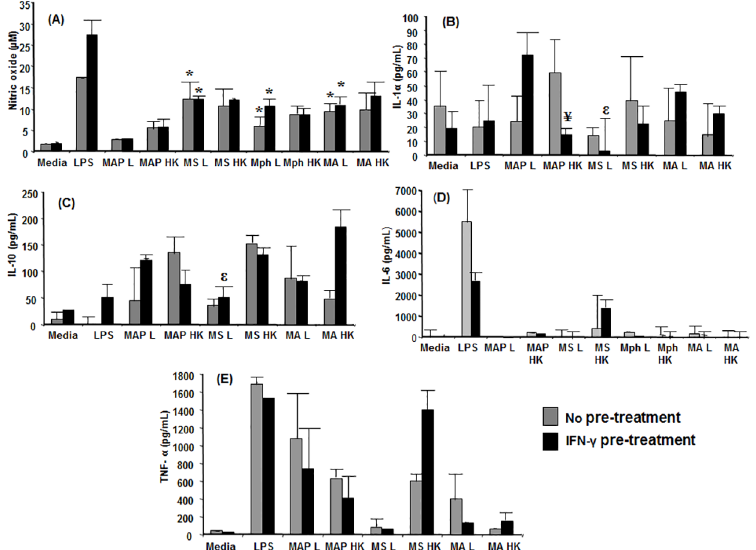
Fig 4. Effect of IFN- γ pre-sensitization on macrophage effector responses to MAP and non- pathogenic mycobacteria. RAW 264.7 cells were incubatedwith MAP or non-pathogenic mycobacterial strains, live (L) or heat-killed(HK), at an MOI of 100 to 1 for a periodof 48 h with or without pre-treatment with IFN- γ . Supernatants were harvestedand assessed for (A) nitric oxide, (B) IL-1 α , (C) IL-10, (D) IL-6 and (E) TNF- α . Data are the mean plus standarderror of three replicate cultures from one of two independent experiments for (A) and triplicate cultures from one experiment for (B-E). MS = M . smegmatis , Mph = M . phlei , Maa = M . avium . * denotesa significantdifference ( P (cid:20) 0.05) compared to MAP (L) in the respectiveno pre- treatment IFN- γ pre-treatment groups. ε is significantdifference( P (cid:20) 0.05) betweenMAP (L) and MS (L) for the IFN- γ pre-treatment group. ¥ is significantdifference between( P (cid:20) 0.05) MAP (L) and MAP (HK) for the IFN- γ pre-treatment group.